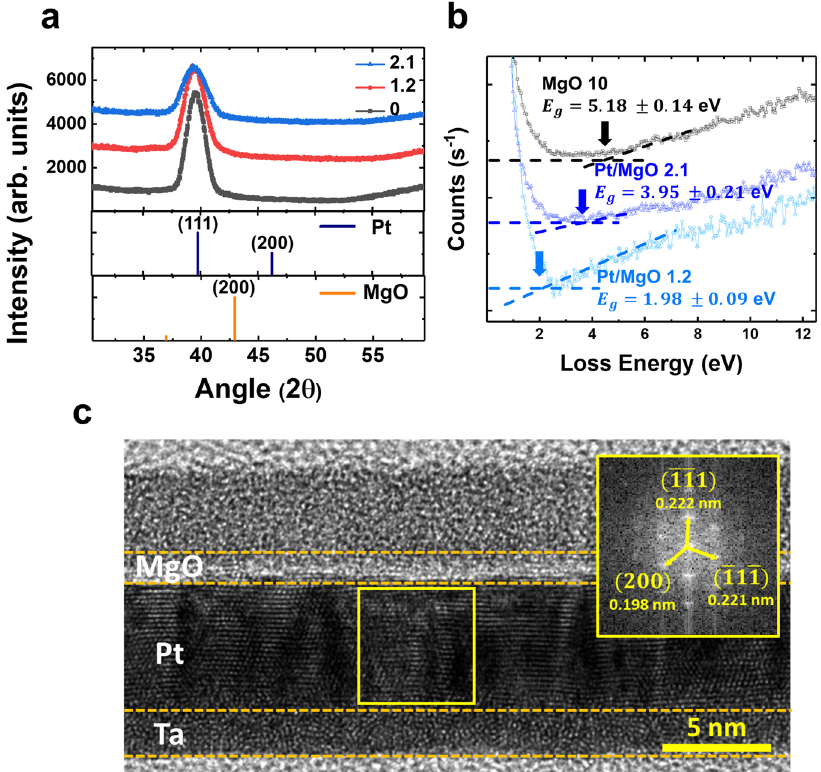
Fig. 3 Microstructural analysis of the MgO inserted structure. a XRD spectra for the as-deposited Ta(3)/Pt(5)/MgO( t MgO )/CoFeSiB(0.9)/MgO(1)/Ta (2) fi lms of various MgO thicknesses. The reference peak positions for Pt (ICDD No. 00-004-0802) and MgO (ICDD No. 00-0004-0829) are shown below the spectra by the vertical lines. b REELS spectra obtained for the as-deposited MgO fi lm (black), Pt/MgO bilayer with MgO thickness of 1.2 nm (light blue), and 2.1 nm (dark blue) at the primary electron energy of 1 keV. c Cross-sectional HR-TEM image of the Ta(3)/Pt(5)/MgO( t MgO )/Ta sample with t MgO = 2.1 nm. The insets in the HR-TEM image consist of the 2D FFT patterns for the corresponding areas. The dashed line is inserted for eye guidance to separate the multilayer fi lm